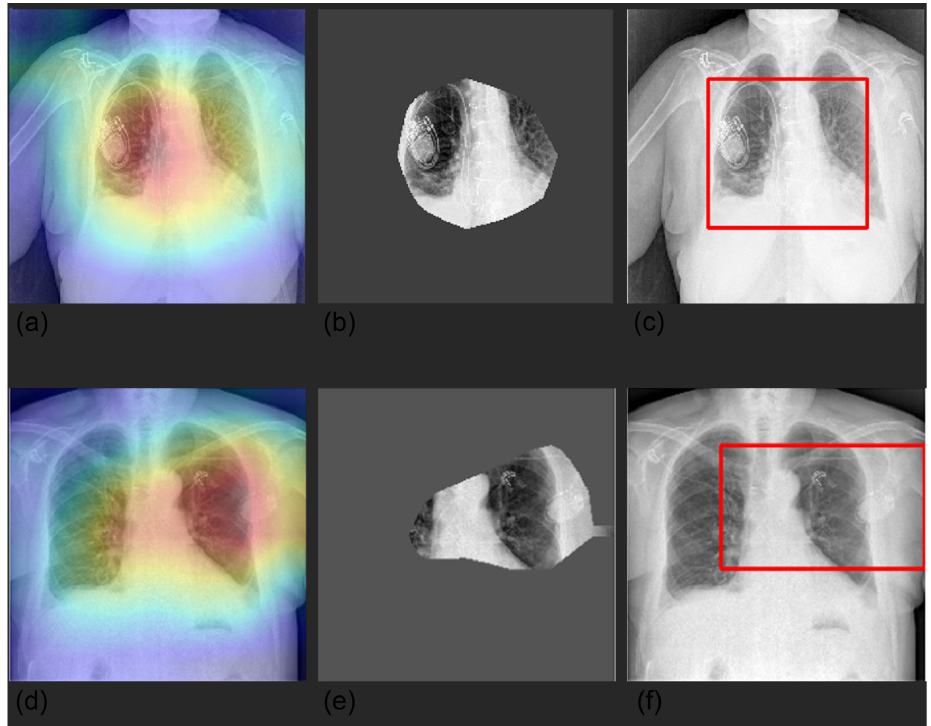
Figure 5. Visualization of device prediction maps for two selected CXRs. The panels represent the saliency mask obtained with Grad-CAM (panels a,d ), the relevant area (mask values higher than the 0.8 quantile) (panels b , e ), and the respective bounding box (panels c , f ). The saliency mask focuses on device (hardware and/or leads), as shown by the heat map (panel a , d ).